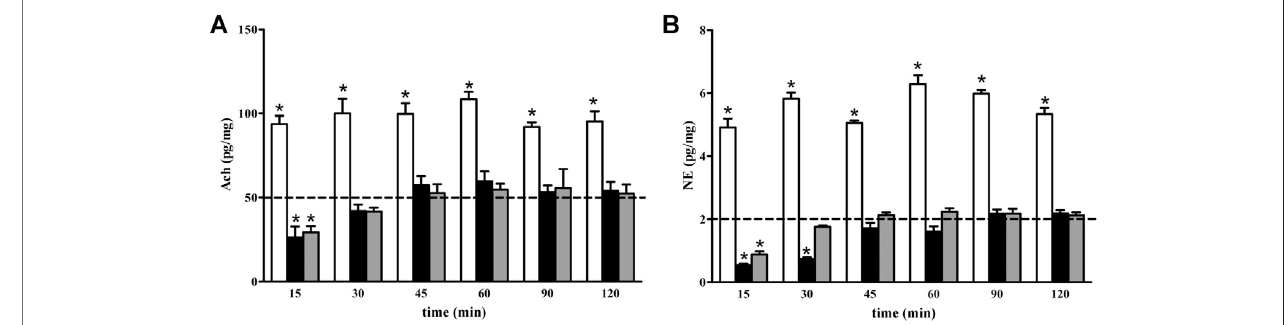
FIGURE5| LongitudinalevaluationofAch (A) andNE (B) levelsfollowing2%GBT(whitecolumns),0.4%BNX(blackcolumns)orGBTafterBNXpretreatment(gray columns).Dataareplottedasmean ± SEM.Thedottedlineindicatesthebasalvalue.Differencesbetweengroupsweretestedforstatisticalsigni fi canceusing two-ways ANOVA with Bonferroni multiple comparison post-test. * p < 0.05 relative to basal, ( n (cid:2) 6 lacrimal glands).